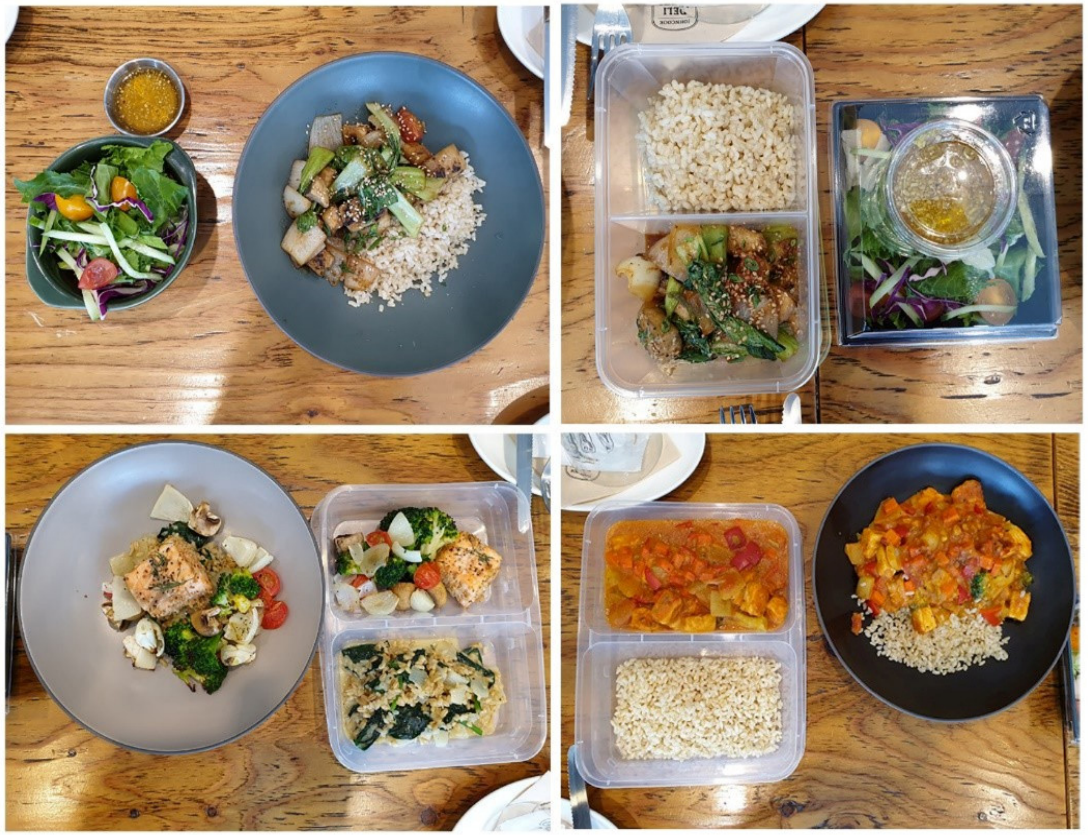
Figure A1. Examples of KMD packages.